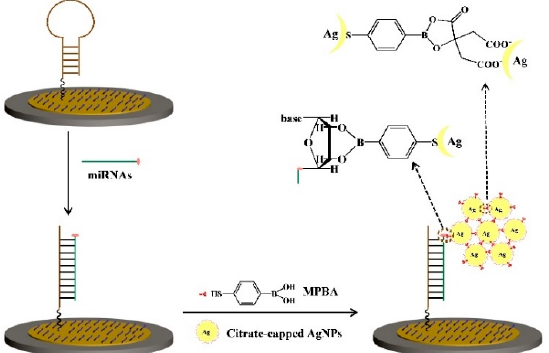
Figure 5. Schematic representation of the proposed electrochemical strategy for miRNAs detection based on MPBA-induced in situ formation of AgNPs aggregates as labels [67]. Copyright 2017 Elsevier B.V.